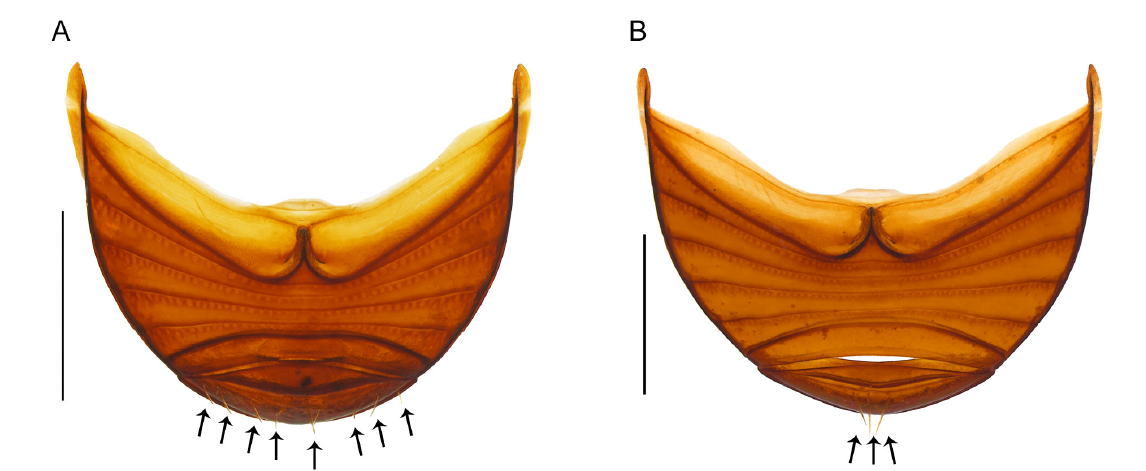
Fig. 2. Ventral view of the abdomen. A . Agamopus unguicularis (Harold, 1883), dissected specimen (CEMT), with one row of several yellow setae along the anterior edge of the pygidial sulcus (black arrows). B . Agamopus castaneus Balthasar, 1938, dissected specimen (CEMT) with three (sometimes two) yellow setae in the centre of the pygidial disc (black arrows). Scale bars = 1